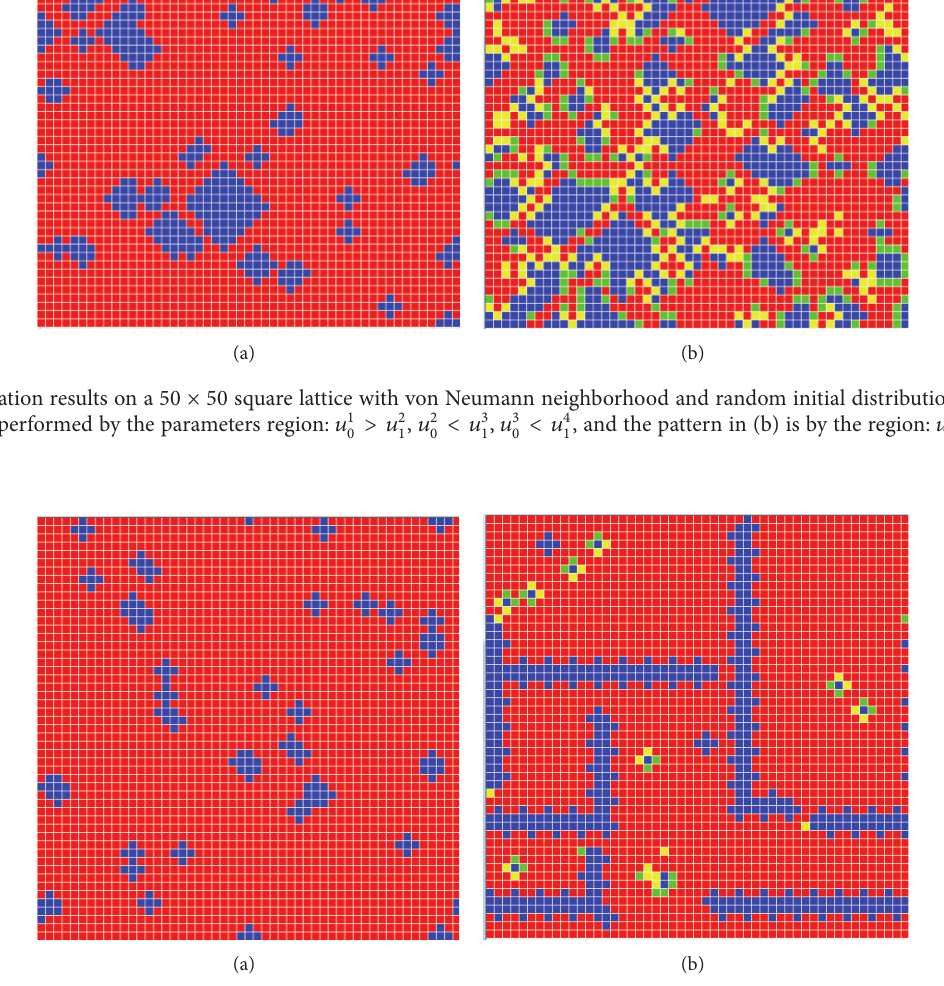
Figure 5: Simulation results on a 50 × 50 square lattice with von Neumann neighborhood and random initial distribution of players. The pattern in (a) is performed by the parameters region 𝑢 1 0 > 𝑢 2 1 , 𝑢 2 0 > 𝑢 3 1 , 𝑢 3 0 < 𝑢 4 1 , and the pattern in (b) is by the region 𝑢 1 0 < 𝑢 2 1 , 𝑢 2 0 > 𝑢 3 1 , > 𝑢 4 𝑢 3 0 1